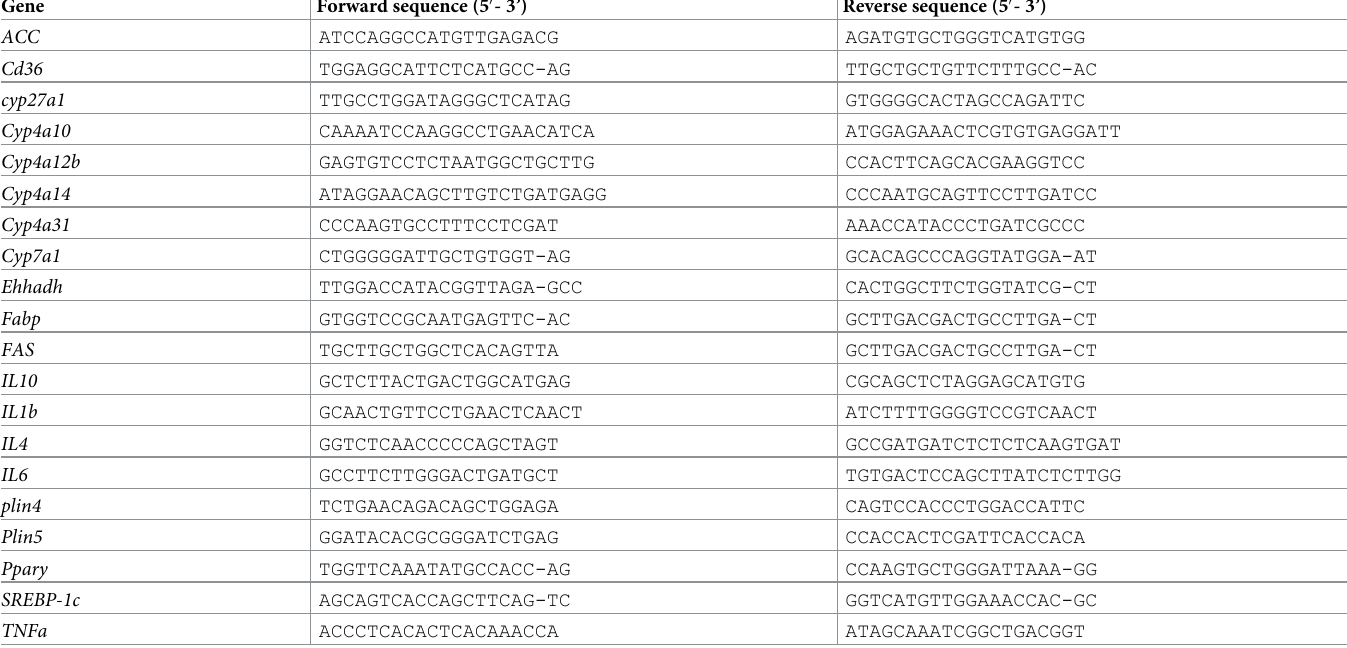
Table 1. Primer used for RT-PCR